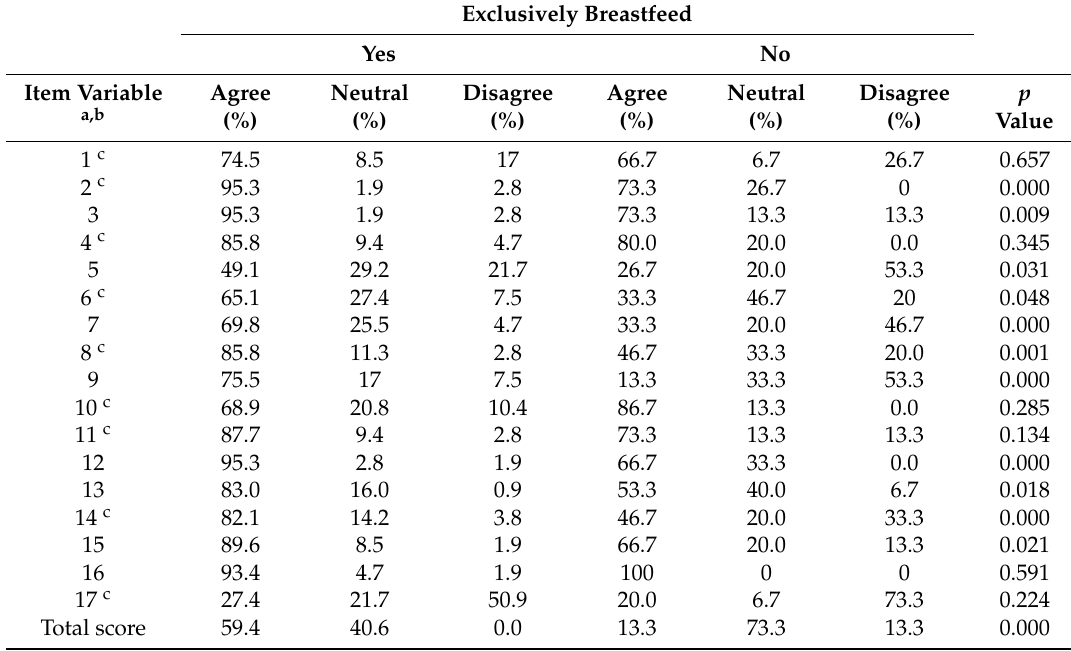
Table 4. Assessment of validity of IIFAS-S items and total scores by intent to